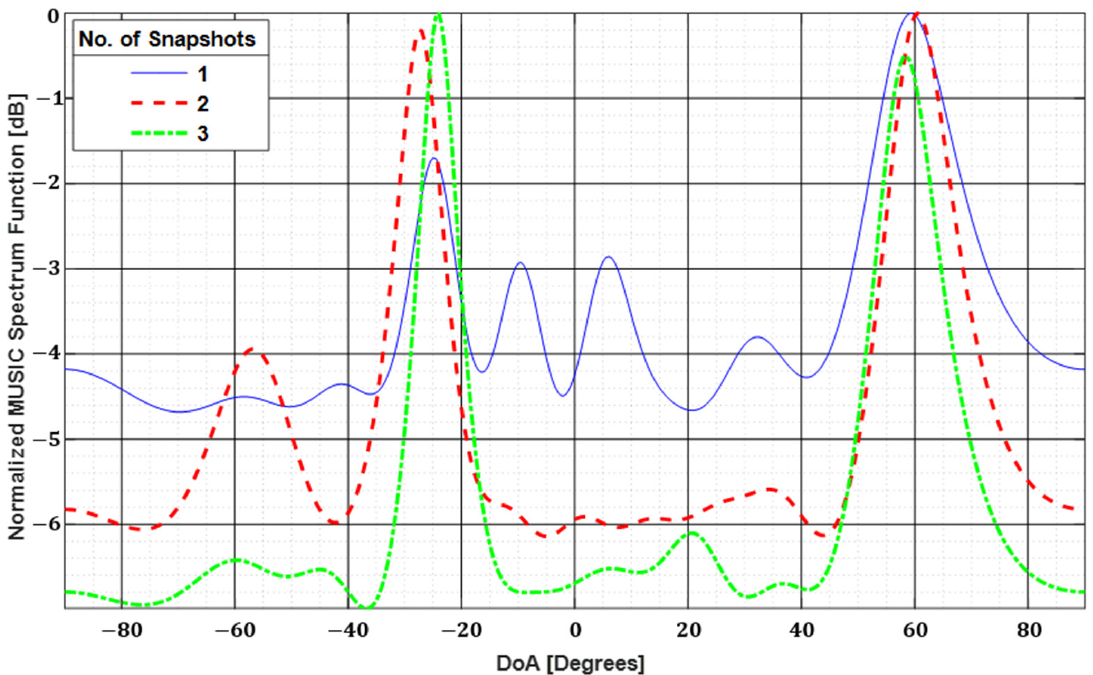
Figure 1. The 1D DoA estimation of two signals incident at − 25° and 60°. Dynamic range and estimation accuracy are increased while side lobes are suppressed by using multiple snapshots of the incident signal.